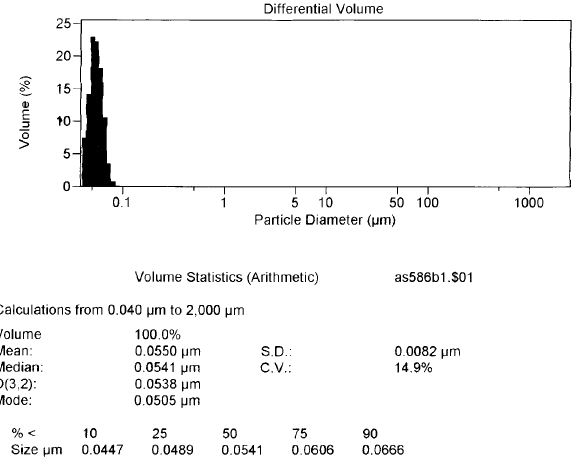
FIGURE 2 Particle size distribution of silver nano-powder.